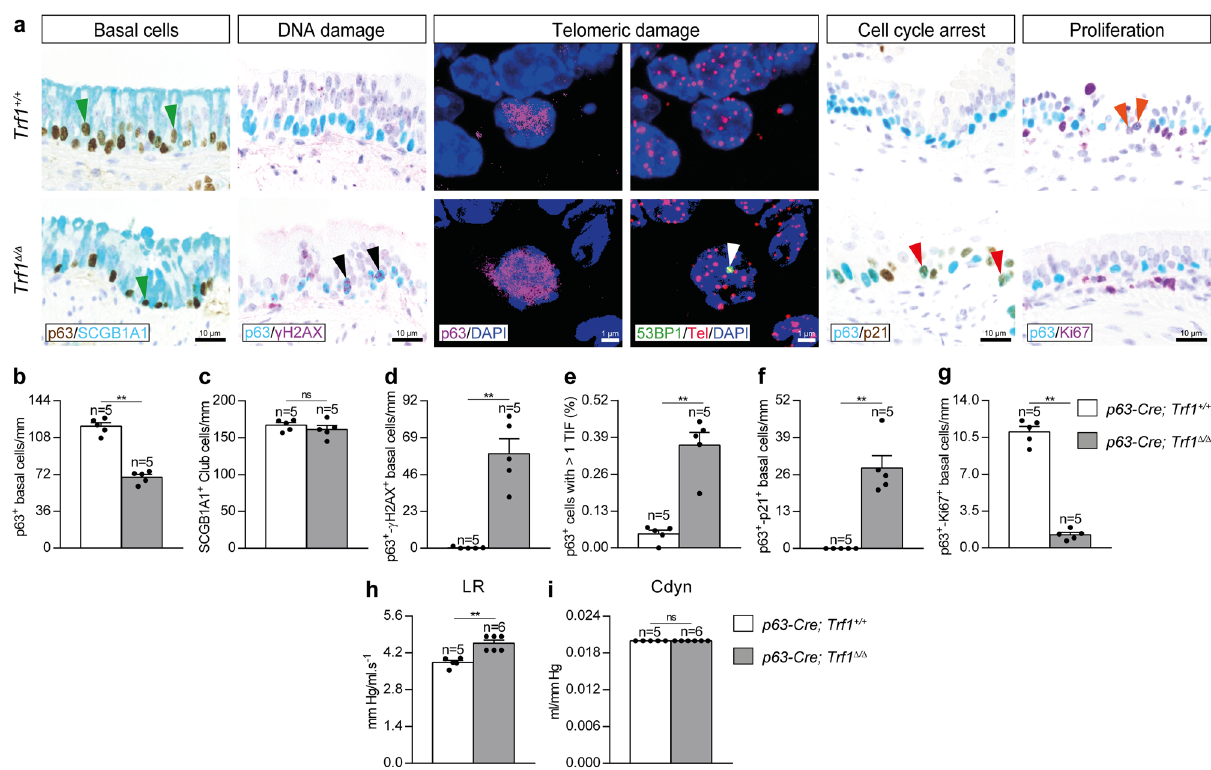
Fig. 9 | Trf1 deletion in basal cells increases telomeric damage and cell cycle arrest, and reduces proliferation of lung basal cells. a Representative immu- nostainings for p63 (blue) and SCGB1A1 (brown; green arrowheads indicate p63 + basalcells),p63 (blue) and γ H2AX(brown;blackarrowheads indicate double p63 + - γ H2AX + basal cells), p63 (blue) and p21 (brown; red arrowheads indicate double p63 + -p21 + basalcells),andp63(blue)andKi67(purple;orangearrowheadsindicate double p63 + -Ki67 + basal cells), as well as representative images of telomeric induced foci (TIF) in p63 + cells (p63 (purple), Cy3Tel probe (red), 53BP1 + cells (green; white arrowheads indicate TIF) and nuclei stained with DAPI (blue)) in lung